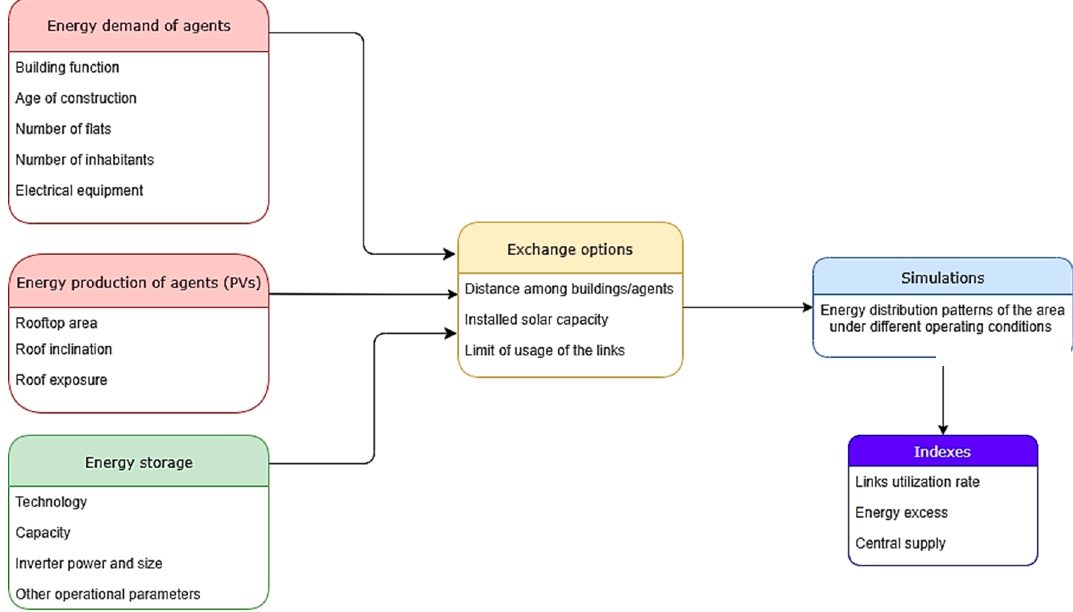
Figure 2. Flowchart of the agent-based model simulating the energy exchanges among prosumers.